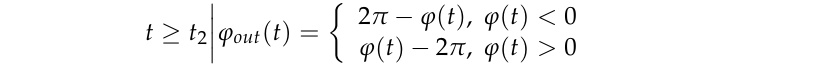
Figure 7. Plotted repolarization of rotation in the joint.